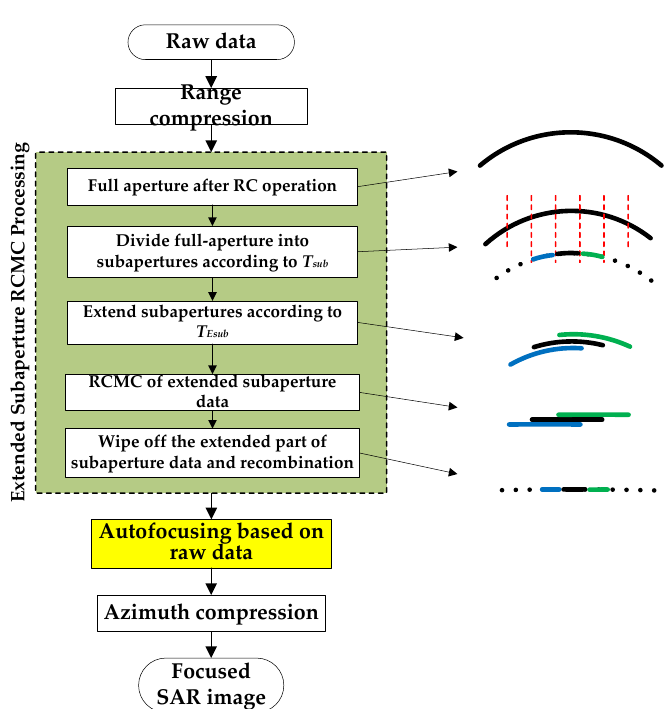
Figure 5. The flow diagram of the extended subaperture imaging processing for UWB SAR.